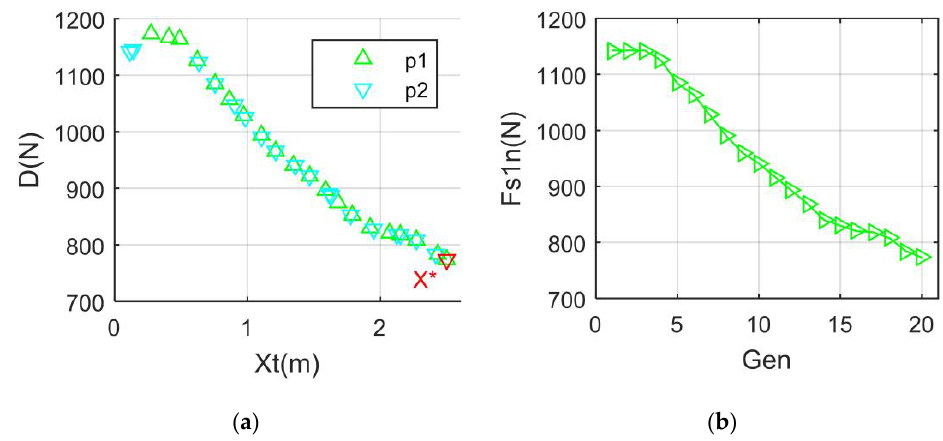
Figure 9. Aerodynamic optimization: X n = 0 m; V ∞ = 125.8 m/s; ( a ) Drag index; ( b ) Min F s1.